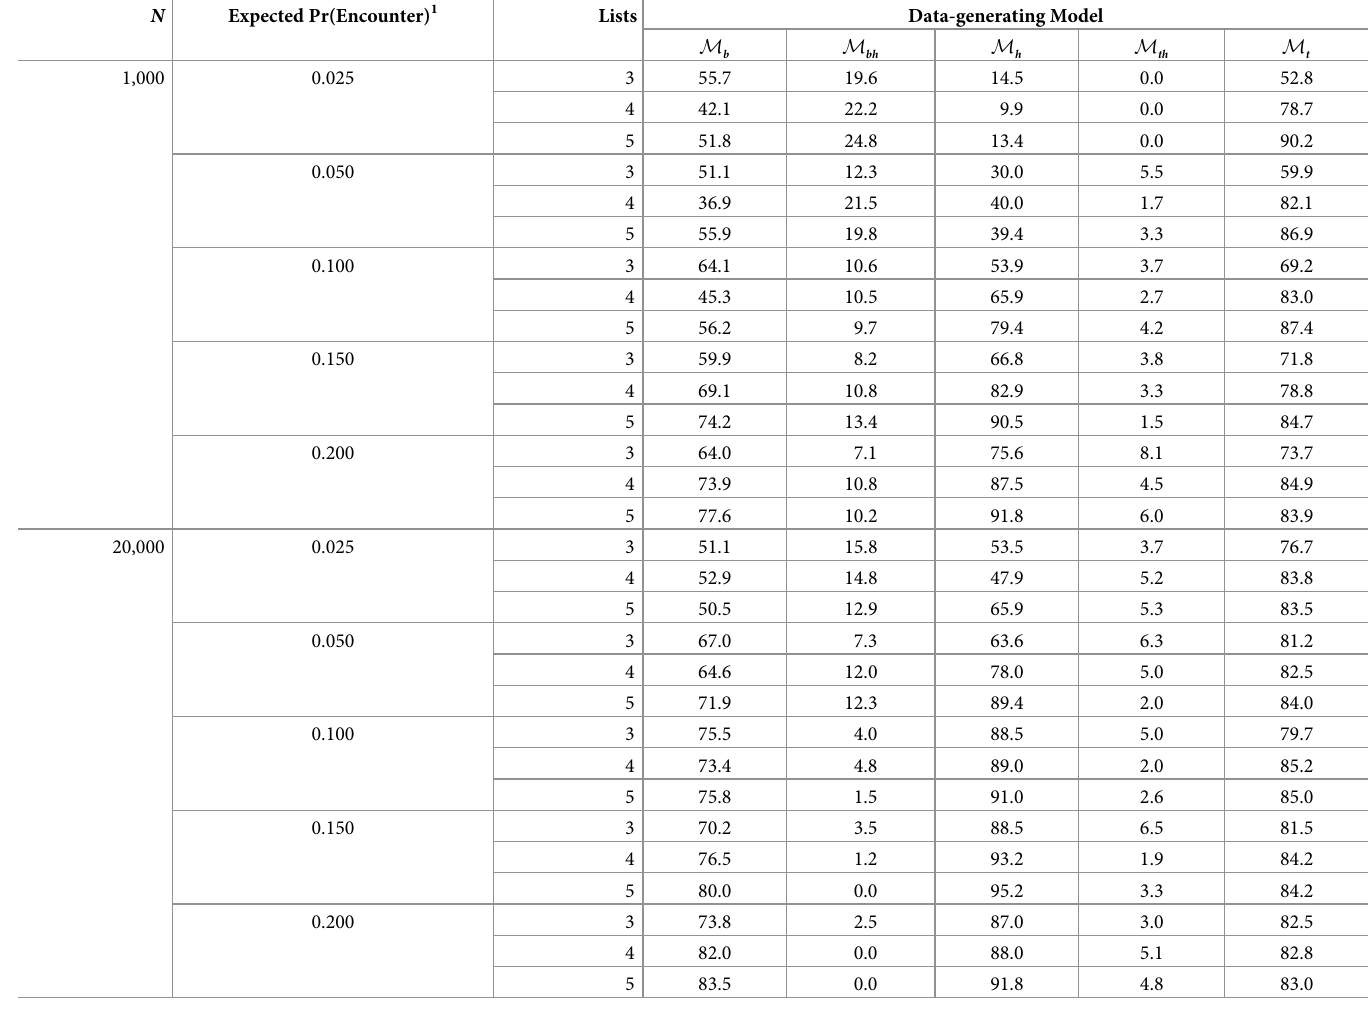
Table 4. Percentages of correct matchings of the data-generating model by the AIC-best LLM population size estimation models based on overlap of 3–5 lists for each of four per-list expected probabilities of encounter. See text for explanation of the data-generating models. N Expected Pr(Encounter)